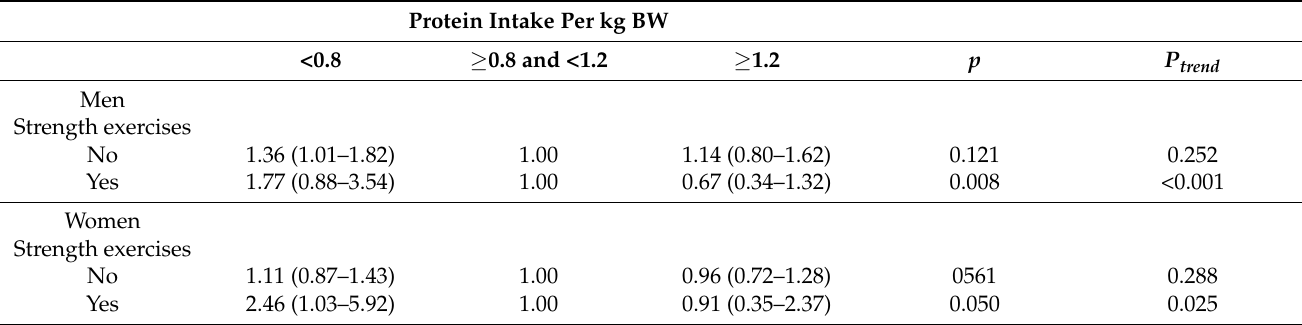
Table 3. Associations of weak HGS with protein intake level according to gender and strength